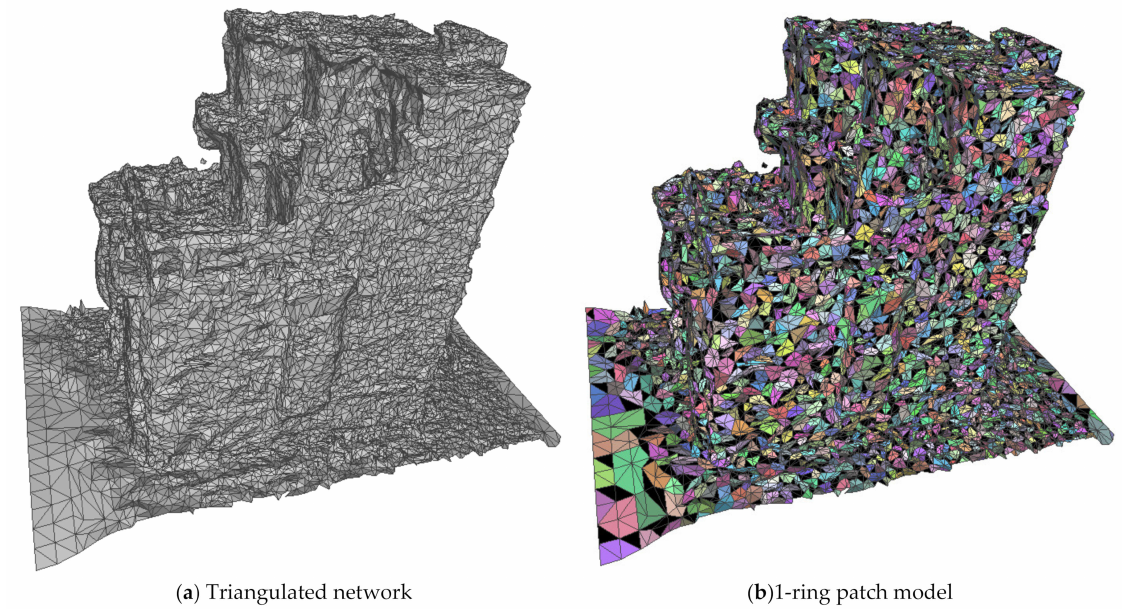
Figure 4. The input MVS building model ( a ) expressed by 37,269 triangular facets can be covered with the 1-ring patch model ( b ) consisting of 4945 patches (each patch is rendered with a random color) and 3496 independent triangular facets (black